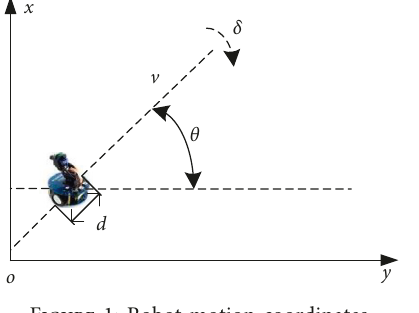
Figure 1: Robot motion coordinates. Figure 2: Environmental state space